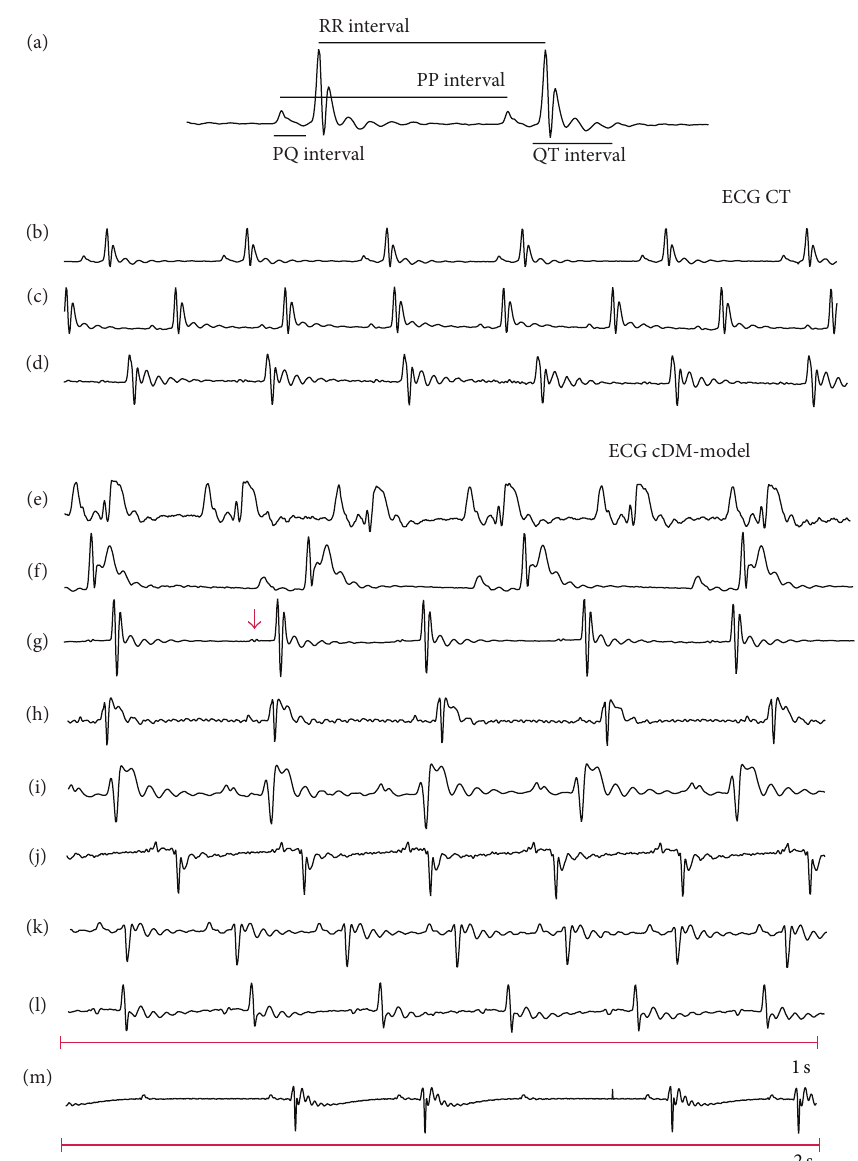
Figure 2: Electrocardiogram recording. (a) ECG intervals (b, c, d) show ECG control conditions. (e–m) ECG from cDM-model. (e, g, h) and (i) have an elevated ST segment. (j) and (k) have a depression QRS complex. (l) P-wave inverted. (g) The arrow show p-notched. (m) Second-degree block. The segments have 1 second of record except in (l) have 2 seconds because block produced intense bradycardia.